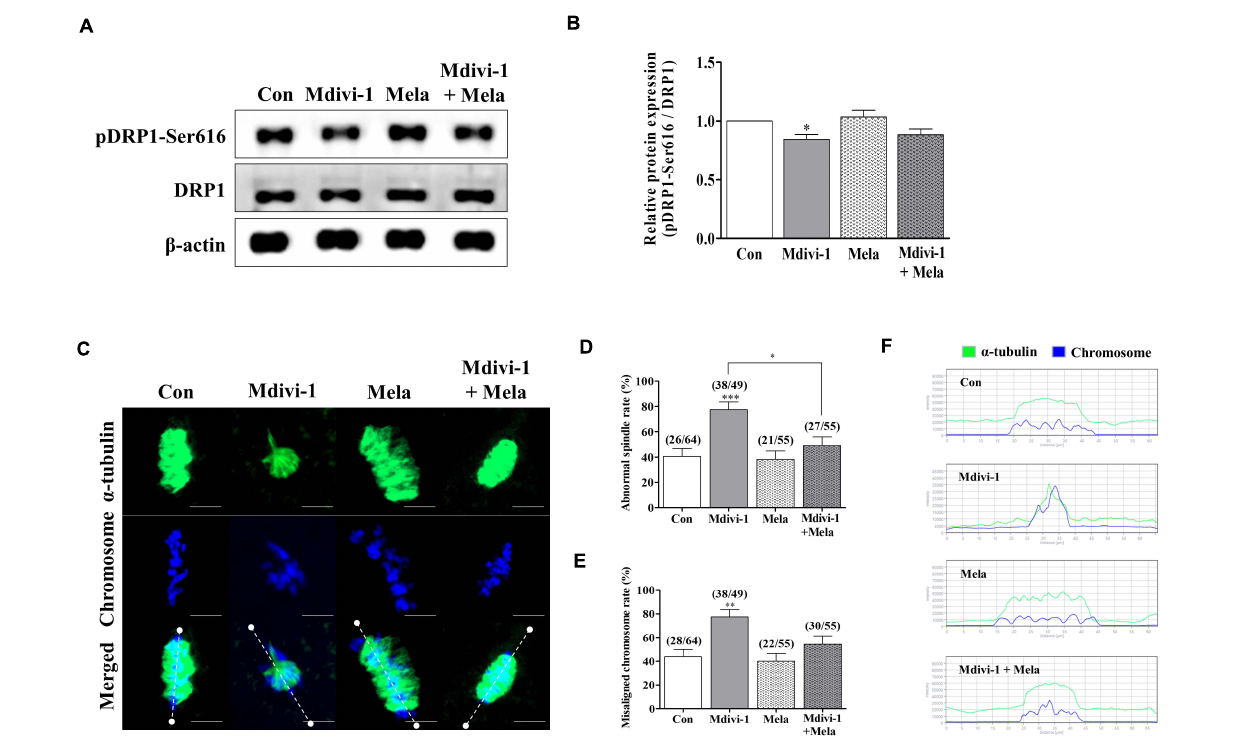
FIGURE 6 | Effect of melatonin on mitochondrial fission and spindle assembly in mature porcine oocytes. (A,B) Representative Western blot of the mitochondrial fission [dynamin-related protein 1 phosphorylation at serine 616 (pDRP1-Ser616) and dynamin-related protein 1 (DRP1)] protein levels in the control, mitochondrial division inhibitor 1 (Mdivi-1), melatonin, and Mdivi-1+melatonin groups. Here, β -actin was used as a loading control. The ratios of phosphorylated/total proteins were calculated and plotted in all experimental groups. (C) Representative images of spindle morphology and chromosome alignment in the control, Mdivi-1, melatonin, and Mdivi-1 + melatonin groups. Green: α -tubulin; blue: chromosome. Scale bar: 10 µ m. Abnormal spindle (D) and misaligned chromosome (E) rates of mature oocytes in the control, Mdivi-1, melatonin, and Mdivi-1 + melatonin groups. (F) Arrangement of spindle assembly in the control, Mdivi-1, melatonin, and Mdivi-1 + melatonin groups. Green: α -tubulin; blue: chromosome. Data represent the mean ± SD/SEM of three biological replicates ( ∗ p < 0.05; ∗∗ p < 0.01; ∗∗∗ p <